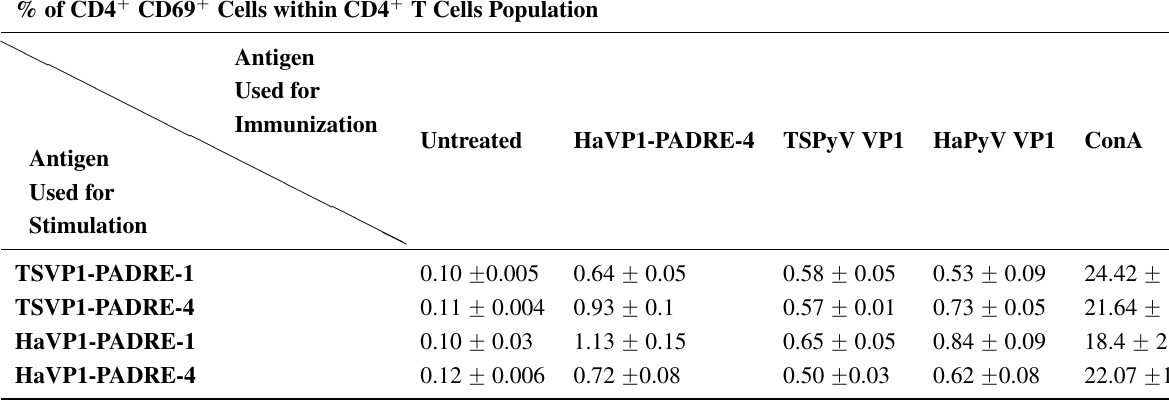
Table 1. The percentages (mean ˘ SD, n = 3) of CD4 ` CD69 ` and CD8 ` CD69 ` T cells in CD4 ` and CD8 ` populations of spleen cell cultures of BALB/c mice immunized with TSVP1-PADRE and HaVP1-PADRE chimeric